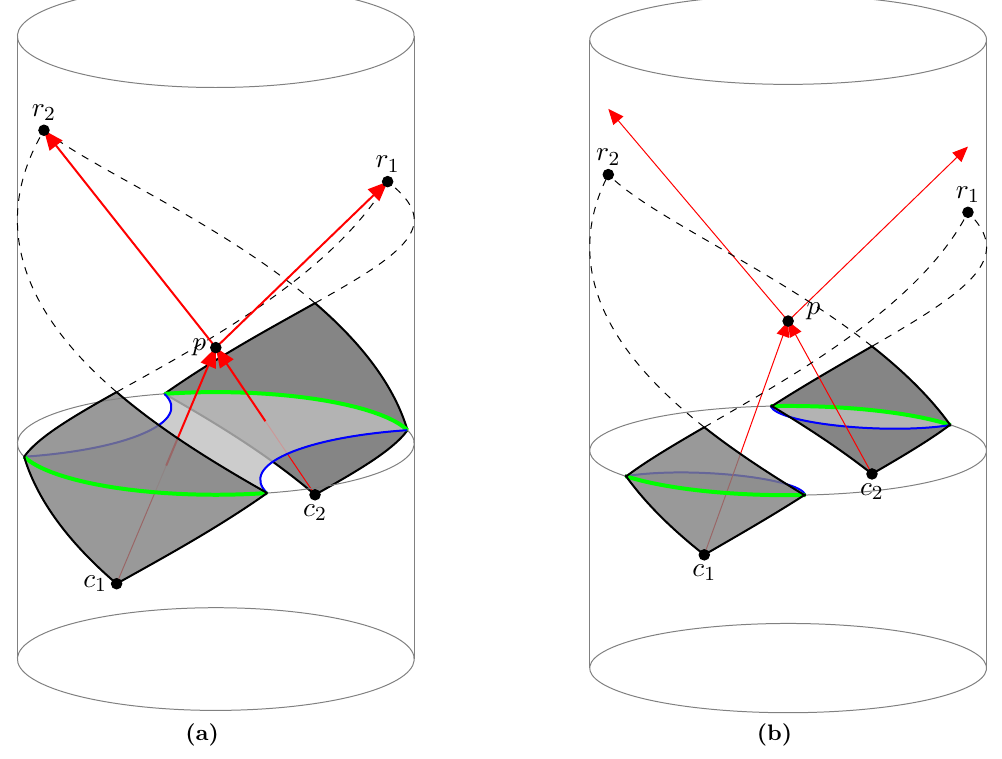
Figure 1. (a) When a set of four boundary points f c 1 ; c 2 ; r 1 ; r 2 g has a bulk scattering region, the entanglement wedge of associated domains of dependence is connected. (b) When there is no scattering region in the bulk, the entanglement wedge need not be connected. See Theorem 1 for a formal statement. This (cid:12)gure is reproduced from